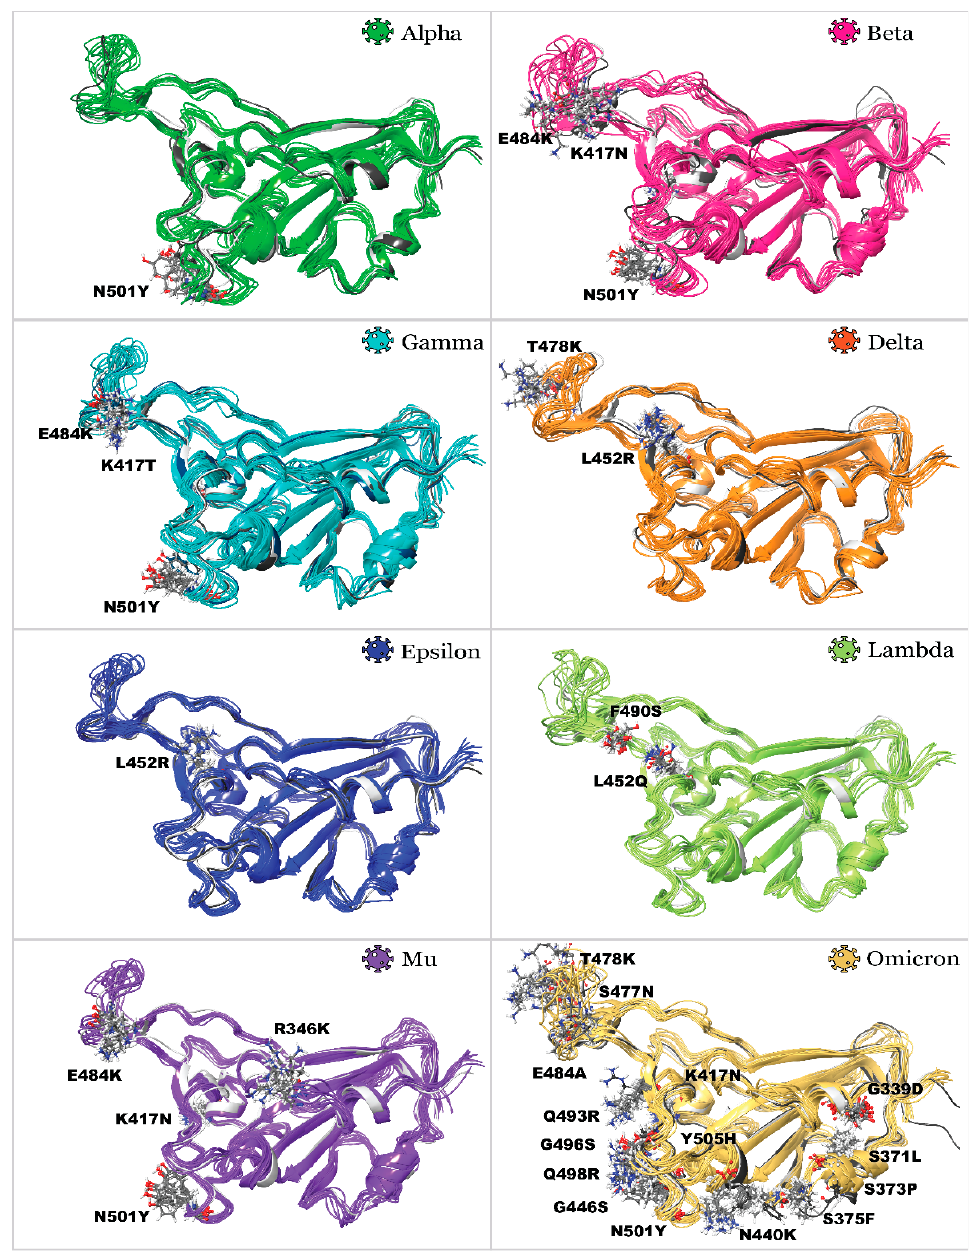
Figure 3. Superposition of 3D structures, illustrating 10 clusters of developed homology models of SARS-CoV-2 variants’ RBDs aligned on Wild type variant and reference PDB structures: mutated residues are labeled.